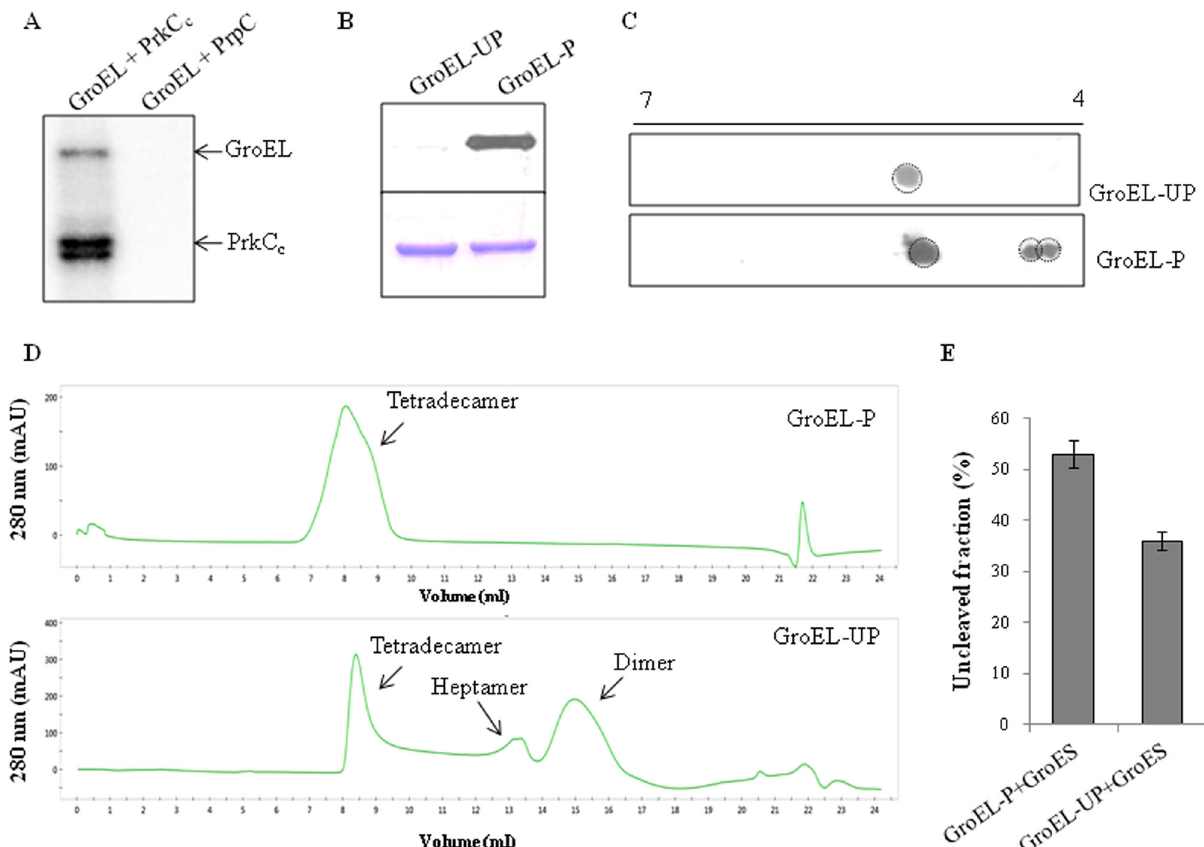
Fig. 4 Co-expression of GroEL with PrkC and PrpC in E. coli and effect of phosphorylation on GroEL: a E. coli BL21 cells overexpressing His 6 - GroEL with either PrkC c or PrpC were metabolically labeled using [ 32 P]orthophosphoric acid. As shown in the autoradiogram, GroEL is phosphorylated in the presence of PrkC. Due to its af fi nity for GroEL, PrkC c was also co-precipitated. b Puri fi ed His 6 -GroEL co-expressed with either PrkC c or PrpC were resolved by SDS-PAGE. The gel was stained with Pro-Q stain and analyzed by Typhoon imager. GroEL was phosphorylated when co-expressed with PrkC c (GroEL-P), while co-expression with PrpC does not result in GroEL phosphorylation (GroEL-UP). c To understand the stoichiometry of phosphorylation of GroEL-P and GroEL-UP, the puri fi ed proteins (1 µg each) were separated by two- dimensional PAGE (pI range 4 – 7). The gels were immunoblotted on nitrocellulose membrane and developed using anti-GroEL antibodies. The images show respective autoradiograms of GroEL-UP ( upper panel ) and GroEL-P ( lower panel ). Multiple species of GroEL-P were observed indicating different levels of phosphorylation. d Gel fi ltration of puri fi ed GroEL-P and GroEL-UP. The graphs show presence of higher ratio of tetradecameric species in GroEL-P ( upper panel ) as compared with GroEL-UP ( lower panel ), which showed majority of dimer and heptamer. e Interaction of GroES with GroEL-P and GroEL-UP were analyzed by proteinase K-mediated partial cleavage. As compared with GroEL-UP: GroES, the phosphorylated GroEL-P:GroES complex was much more protected from protease cleavage indicating a stronger interaction. The experiment was performed thrice and the error bars show the SE of three independent